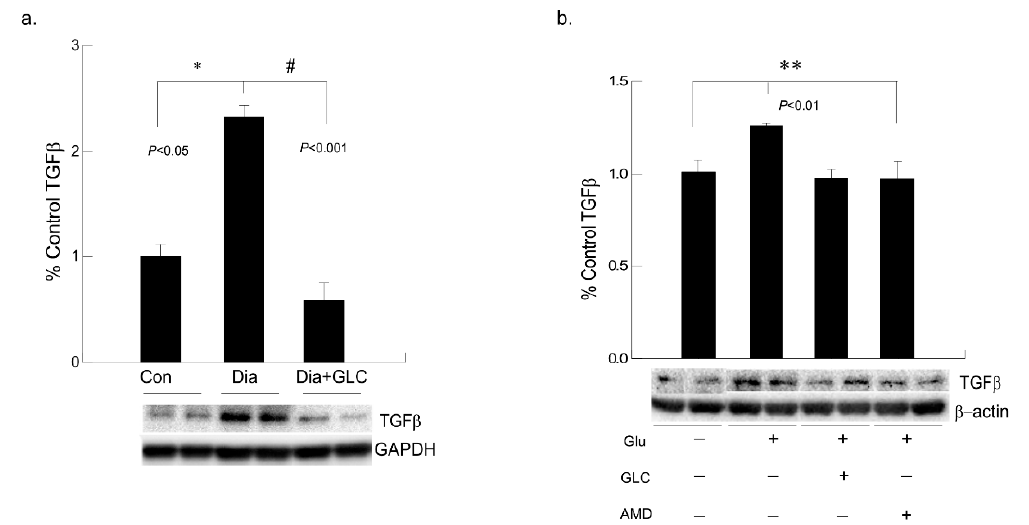
Figure 7. Hyperglycemic cardiac tissues and cardiomyocytes cells exhibited increased TGF β expression which was ameliorated with CXCR4 antagonist in vitro and with GLC both in vivo and in vitro. ( a ) Fibrotic marker TGF- β was evaluated in cardiac tissue of ZDF rats which showed a marked increase compared to the lean control group (* p < 0.05). Four weeks of GLC treatment decreased TGF β expression significantly in the cardiac tissue of ZDF rats (# p < 0.001). ( b ) Hyperglycemic AC-16 cardiomyocytes (Glu +) showed increased TGF β expression whereas treatment with CXCR4 antagonist, AMD3100 (AMD +) showed significant decrease in TGF- β expression similar to the GLC treatment (GLC +; ** p < 0.01).